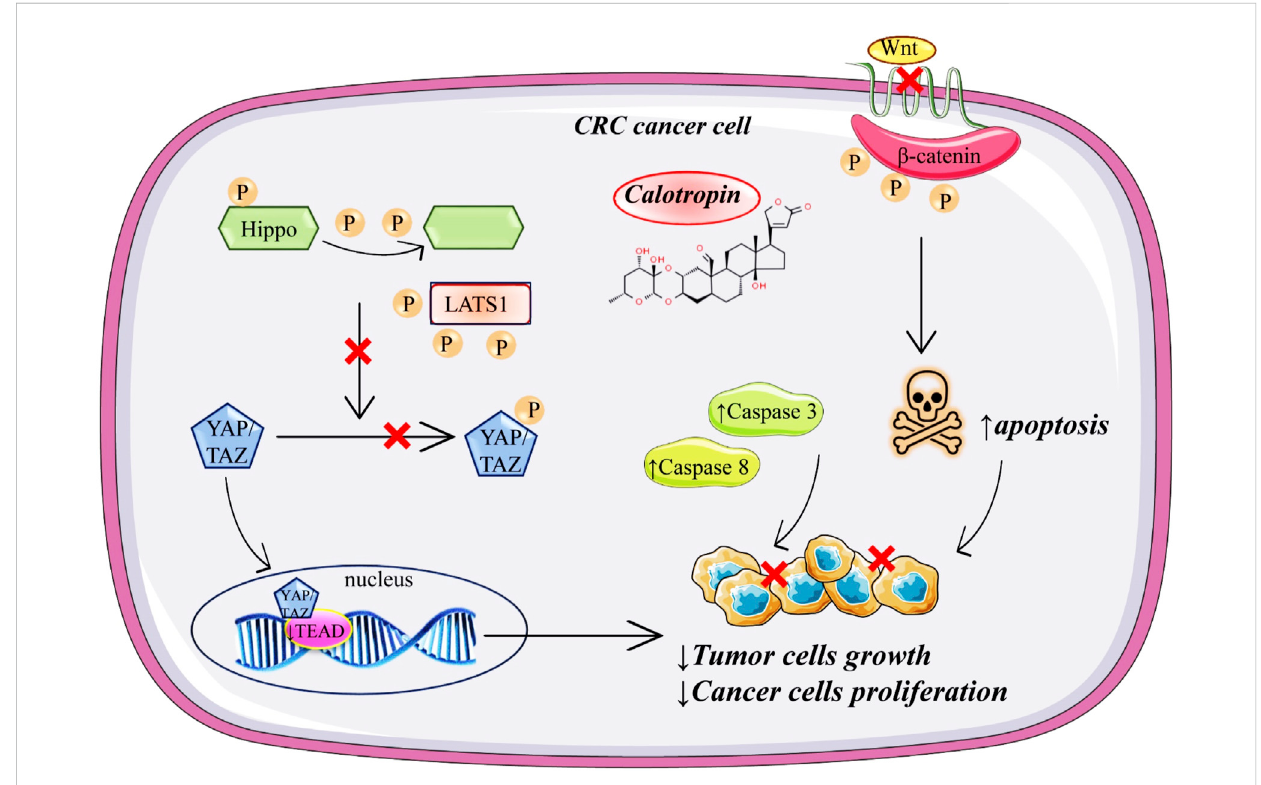
FIGURE 3 Schematic representation of anticancer mechanisms of calotropin in colorectal